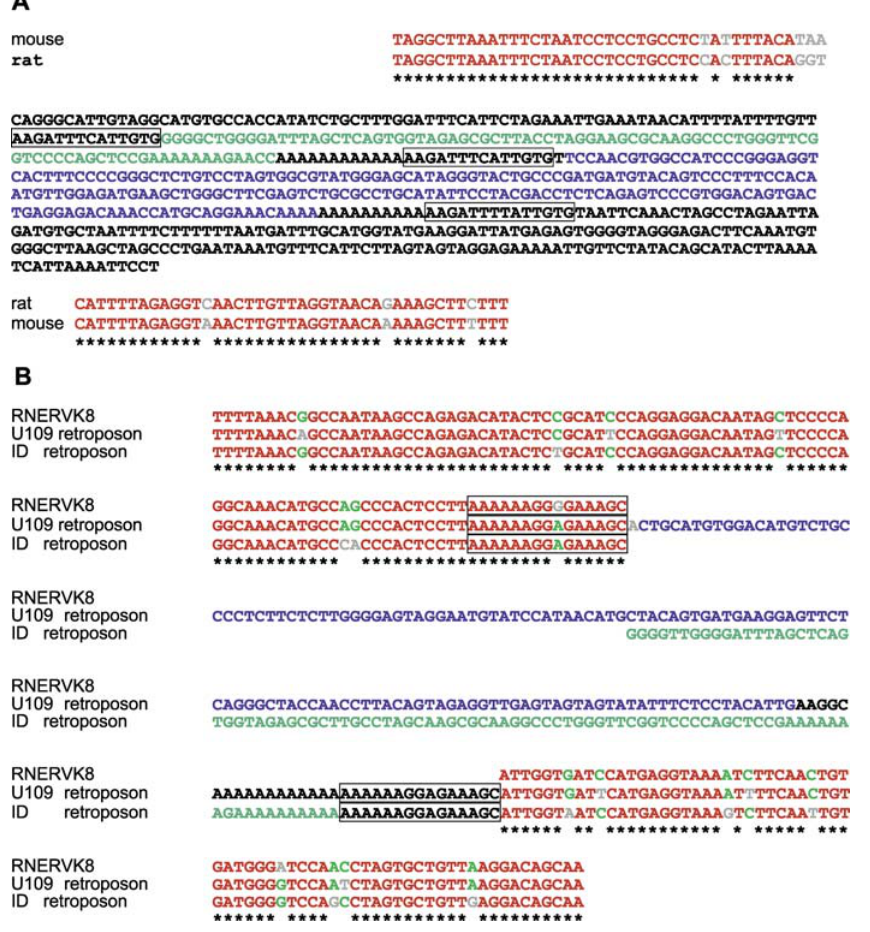
Figure 3. sno/scaRNA Retroposons and ID Elements Insert at Identical Sites in the Rat Genome (A) Rat-specific U17 retroposon and its corresponding insertion site in the mouse genome. This retroposon, located in an intron of the Pdia3 gene in the sense orientation, is part of a rat-specific insertion containing a full-length ID sequence and the U17 snoRNA copy (green and blue letters, respectively), embedded in 90-bp and 113-bp sequences of unknown origin. The triplicated target site is boxed. Sequences shown are chr3:108128544–108129247 (rat) and chr2:121165874–121165955 (mouse). (B) Rat-specific U109 scaRT. This perfect copy of rat U109 is inserted in an extragenic region within an RnERVK8 repeat. Alignment with a typical RnERVK8 element precisely delineates the insertion site and the TSD (boxed). At a different genomic location, an ID element is inserted at the same position, with the same TSD. Note that the ID sequences from A and B display 90/93 nt identity. Sequences shown are: RnERVK8: chr12:18586394– 18586560; U109 retroposon: chr7:118265612–118265946; and ID retroposon: